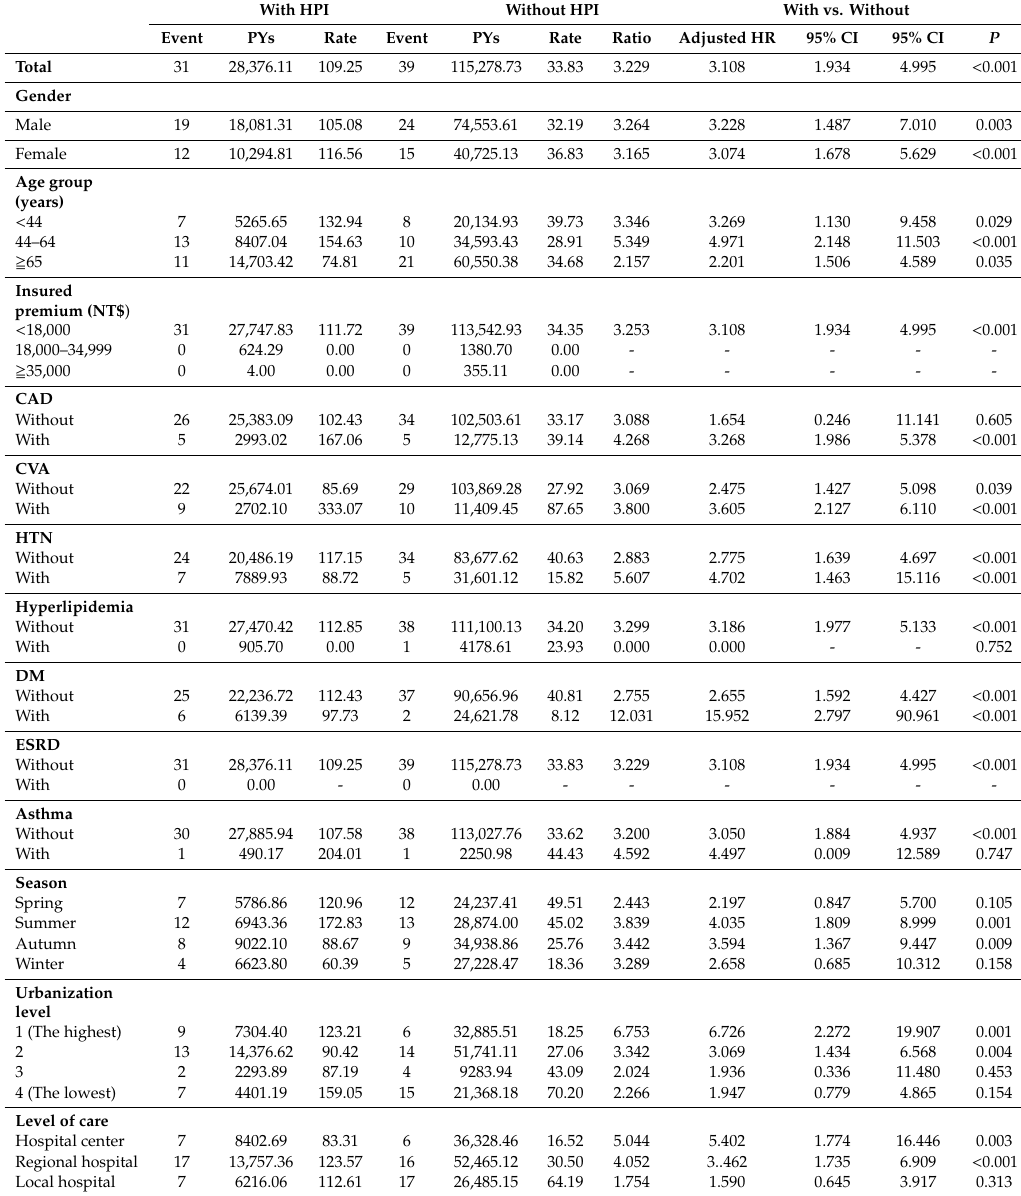
Table 3. Factors of irritable bowel syndrome (IBS) stratified by variables listed in the table by using Cox regression.